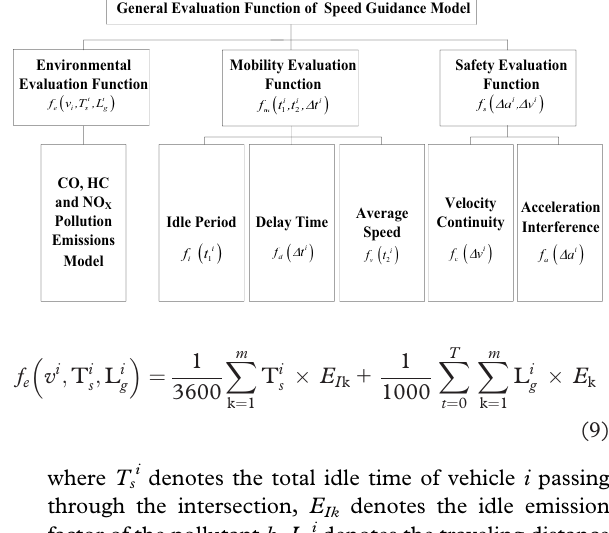
Figure 5 Architecture of the general evaluation function General Evaluation Function of Speed Guidance